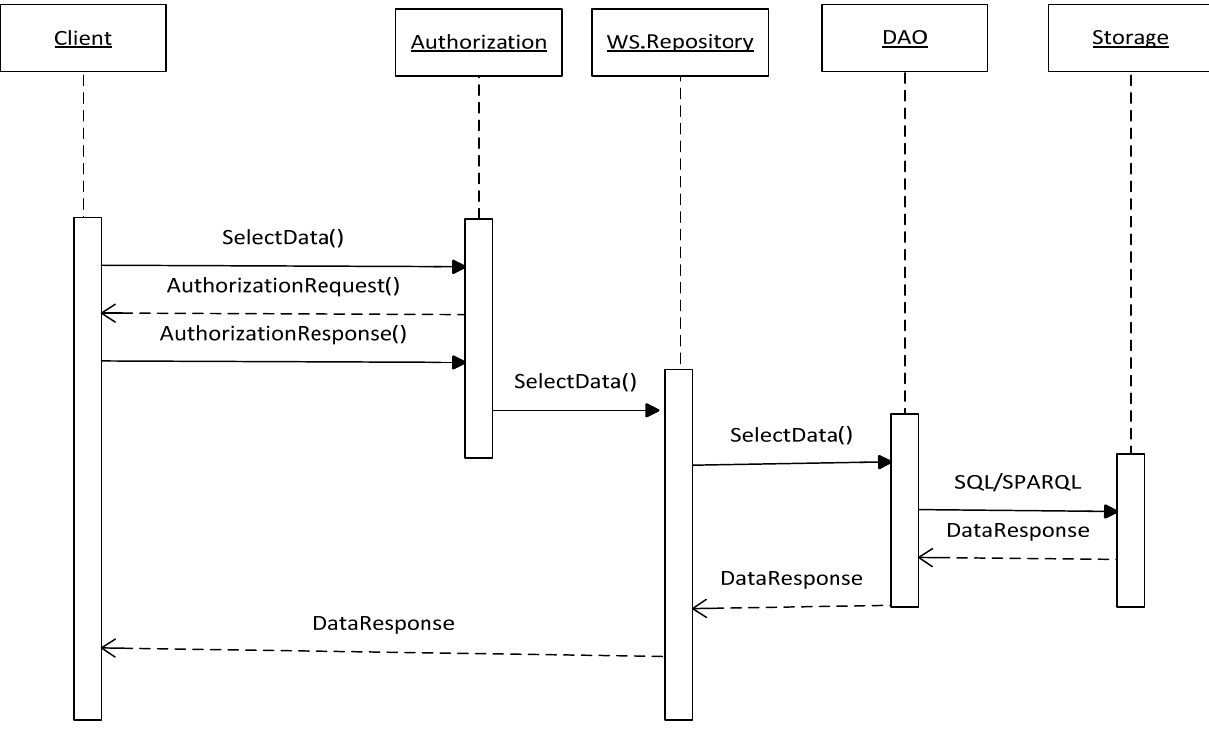
Figure 9. Sequence diagram of the repository and client